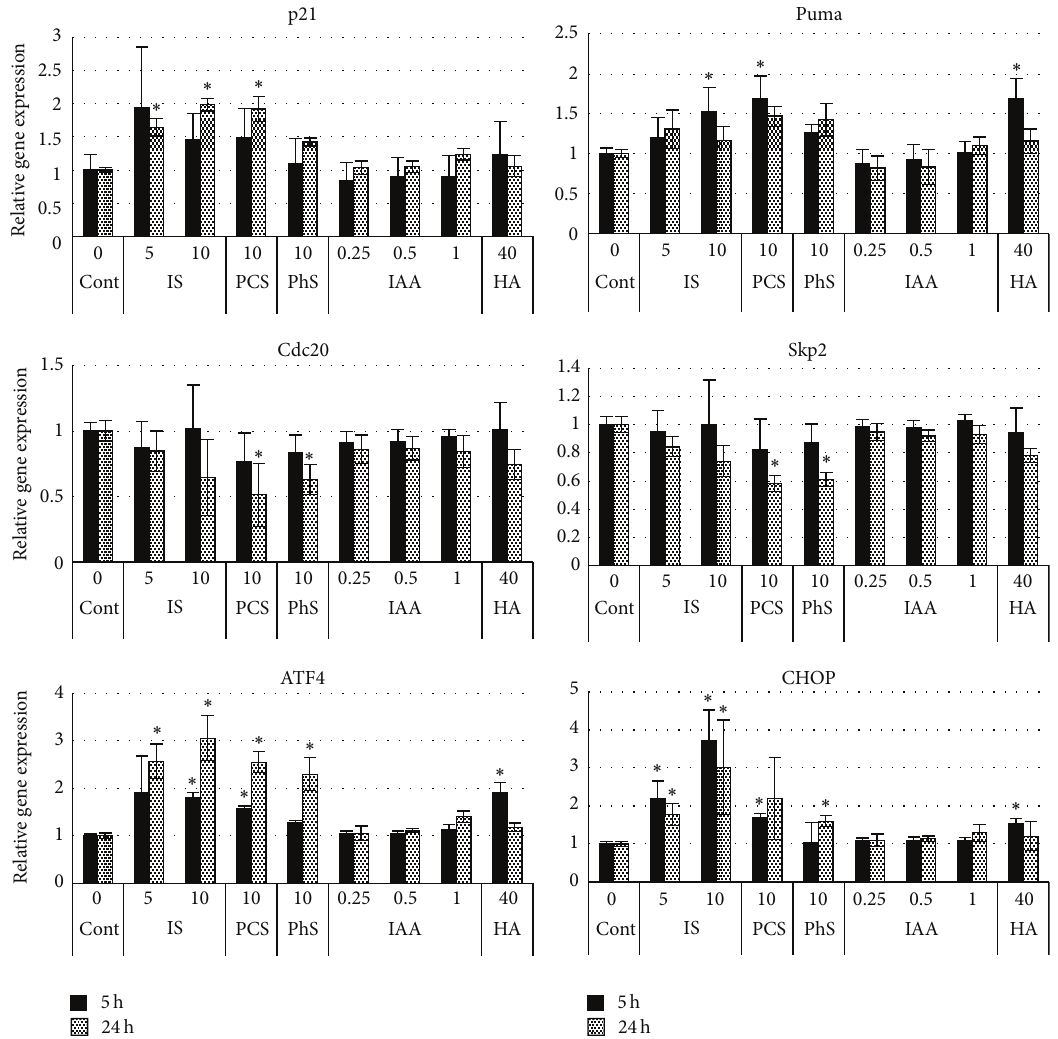
Figure7:Effectsofuremicsolutesongeneexpression.Porcinerenaltubularcellsweretreatedwitheachuremicsolutefor5and24hours.Total RNA was extracted and subjected to real-time PCR. Gene expression level relative to GAPDH expression was calculated by ΔΔ Ct method. Data are expressed as relative values to the corresponding control. Cont, control; IS, indoxyl sulfate; PCS, p -cresyl sulfate; PhS, phenyl sulfate; HA, hippuric acid; IAA, indoleacetic acid. Data are shown as mean ± S.D. ( 𝑛 = 6 ). Asterisks indicate more than 1.5-fold increase or decrease with statistical significance compared to corresponding control ( 𝑃 < 0.01